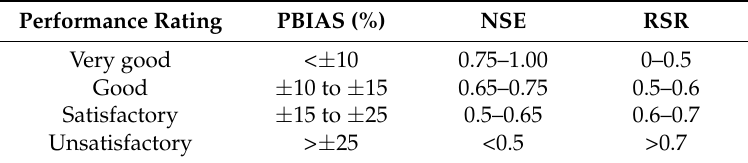
Table 3. Model performance rating based on Moriasi et al. (2007)